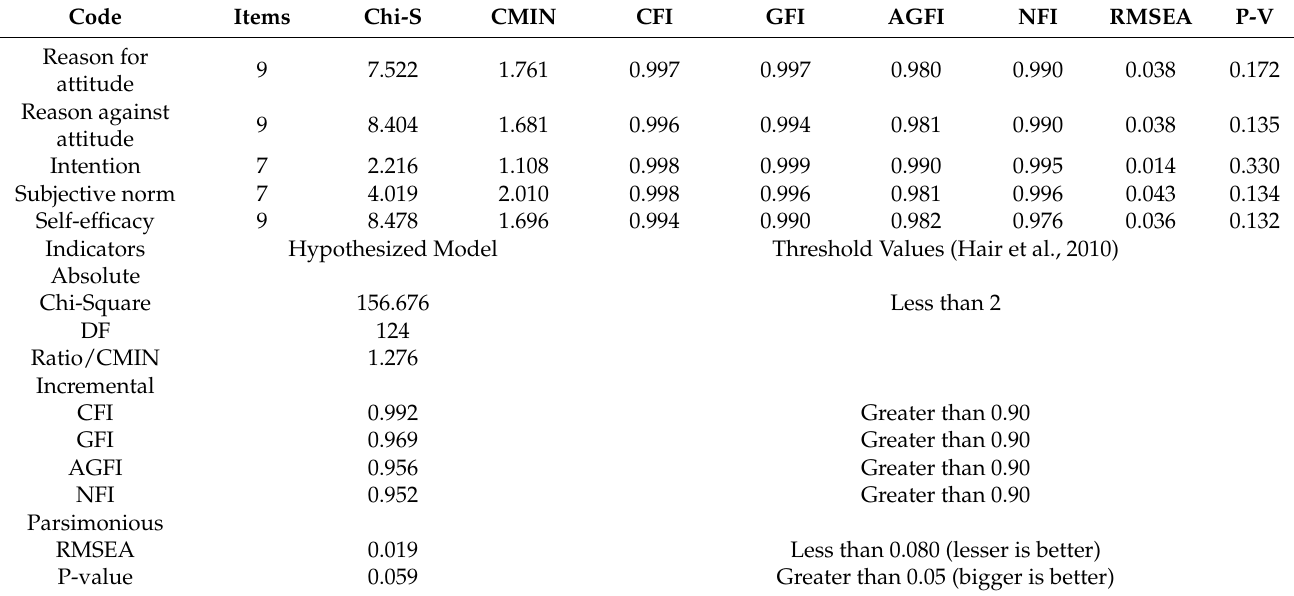
Table 2. Confirmatory factor analysis and model fitness.